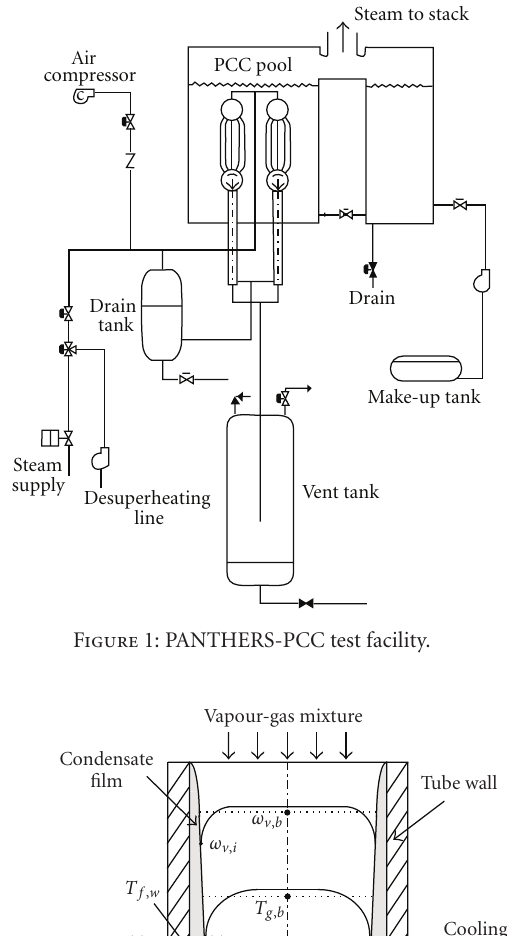
Figure 2: Physical model adopted for film condensation in